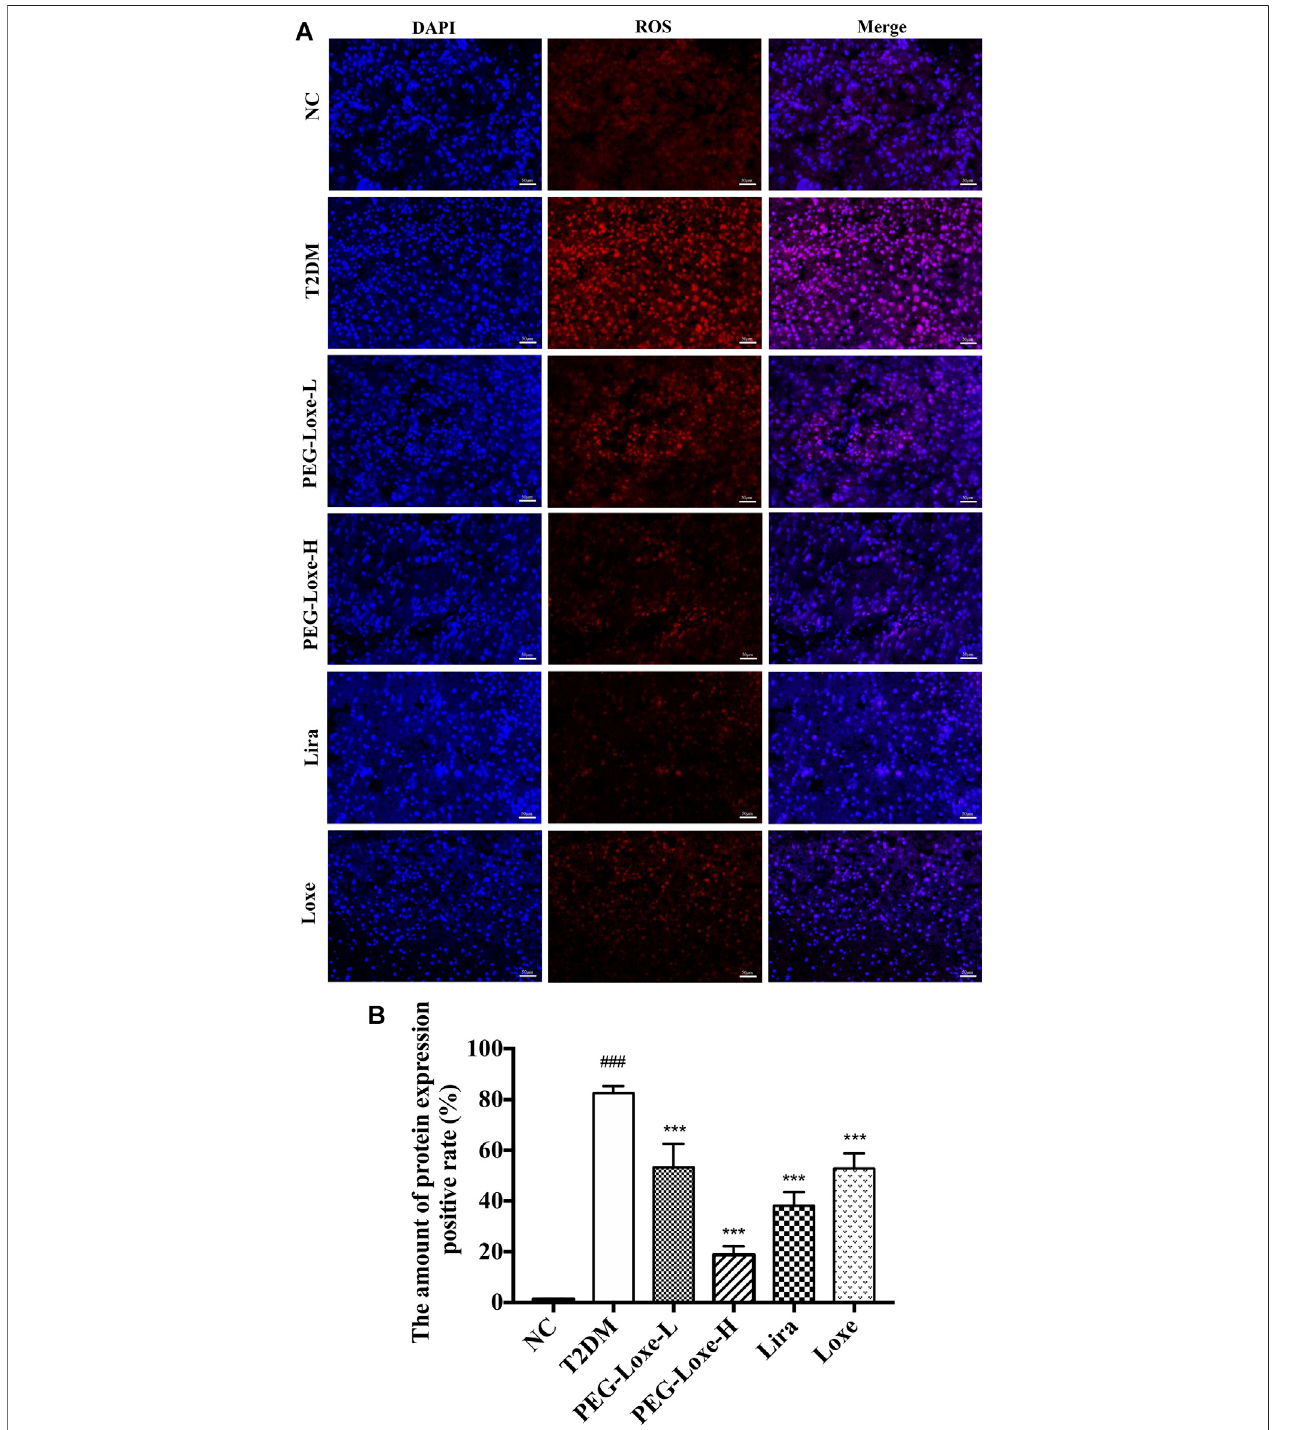
FIGURE 4 | Polyethylene glycol loxenatide (PEG-Loxe) reduced ROS levels in db/db mice (A) Representative images of reactive oxygen species (ROS) levels after dihydroethidium (DHE) staining (200 × ) (B) ROS levels expressed as the ratio of the fl uorescence intensity of the DHE-positive area to 4 ′ ,6 ′ -diamidino-2-phenylindole (DAPI).Dataarepresentedasthemean ± SD;n (cid:2) 3; ## p < 0.01and ### p < 0.001comparedtothenormalcontrolgroup;* p < 0.05,** p < 0.01,and*** p < 0.001compared to the T2DM